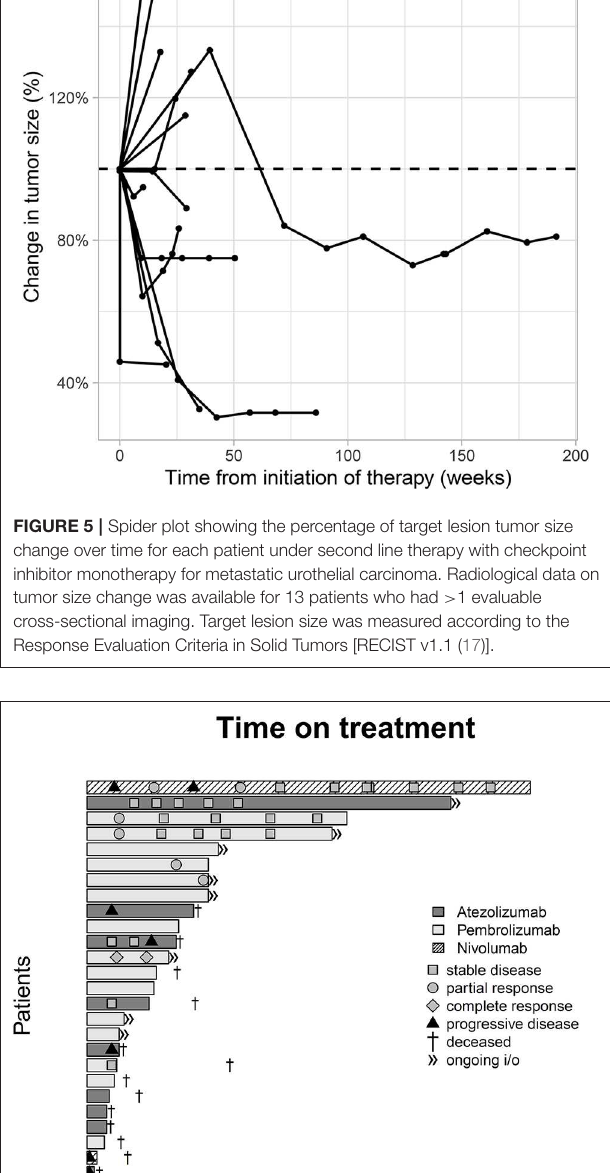
of checkpoint inhibition showed a PFS of no longer than 2.1 months in all trials (10, 12, 13, 19). This discrepancy is most likely due to the fact that our study population is still